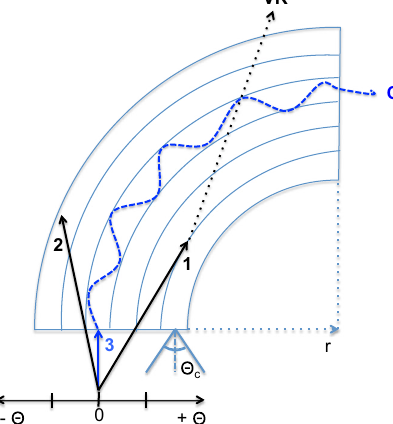
Fig. 2 Schemeofthedifferentcoherentprocessesofapositivecharged particles in a bent crystal. Volume reflection occurs when the particle incoming angle is positive and inside the interval between the critical and the bending angle ( θ c < θ in < θ b ): the atomic density increases because the crossing angles of the crystal planes decrease (particle 1). For negative particle incident angle it encounters atomic planes at increasing angles and the atomic density continuously decreases to the amorphous density value (particle 2). Planar channeling is possible when the incident angle of the particle is smaller than the channeling critical angle ( θ in < θ c ) and it is deflected by the crystal bending angle (particle